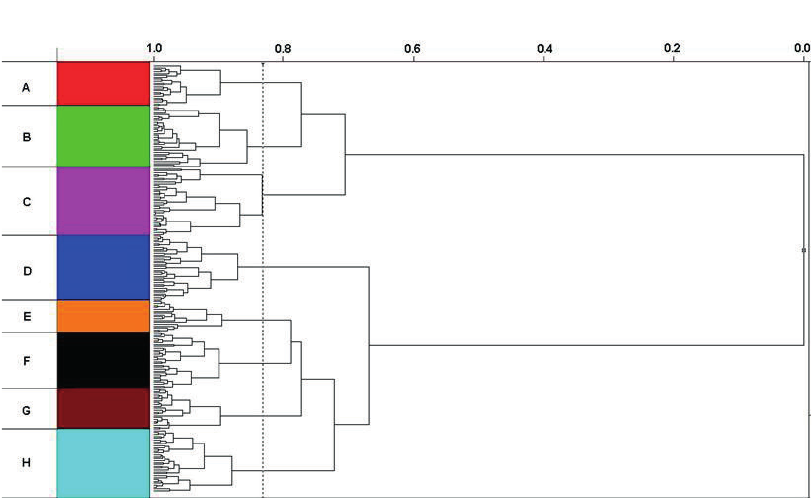
Figure 2 - Dendrogram obtained from the HCA using an X data matrix (228x7): Ward/ Incremental method and Euclidean distance. The dashed line indicates with 83.2% the similarity of the cows.